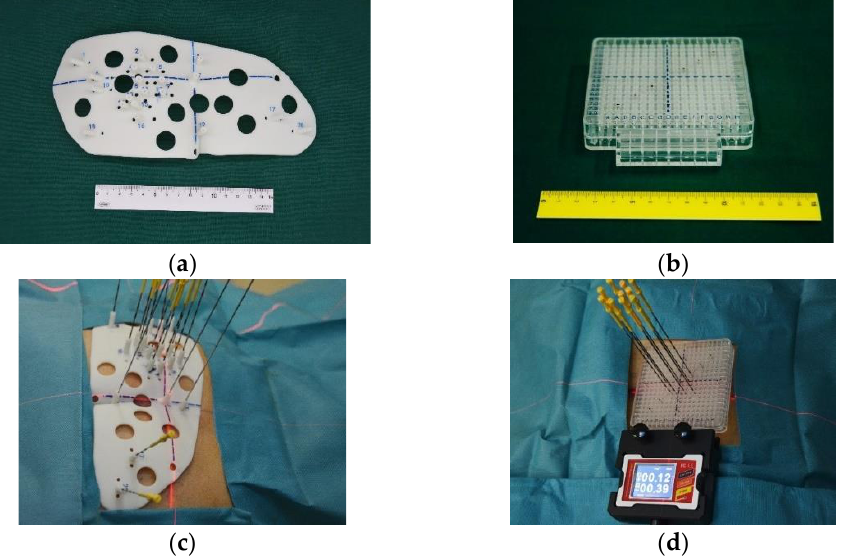
Figure 2. ( a ) Real product of 3DPNCT and ( b ) 3DPCT. ( c ) 3DPNCT and ( d ) 3DPCT immobilized with stable needles in seed implantation for recurrent cervical cancer.